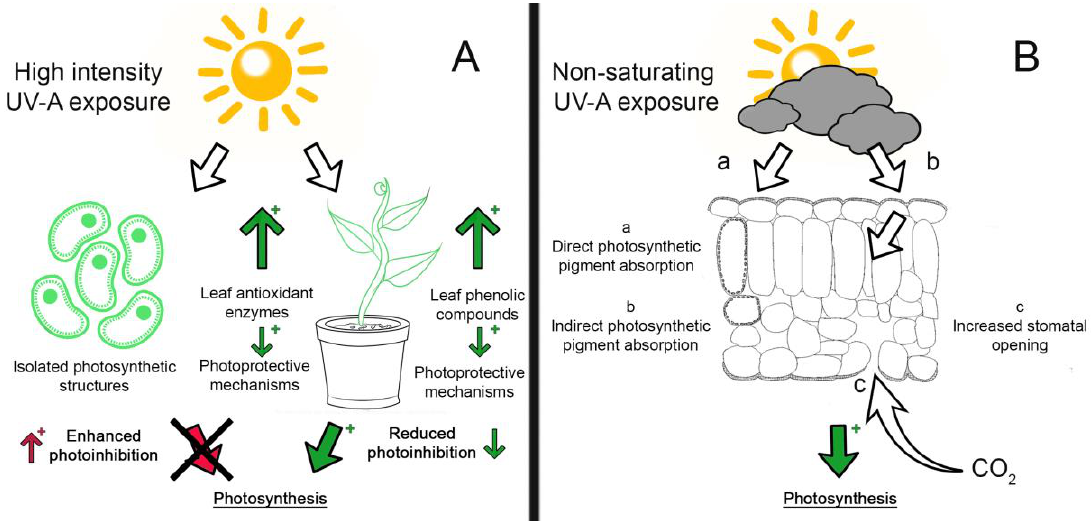
Figure 1. UV-A effects on photosynthesis. A plus (+) sign indicates enhanced response (either positive or negative); a green arrow indicates a positive response, and a red arrow indicates a negative response. ( A ) High intensity UV-A exposure enhanced photoinhibition in isolated photosynthetic structures (chloroplasts and thylakoids), whereas leaves exposed to UV-A activate photoprotective mechanisms (leaf phenols and antioxidant enzymes), reducing photoinhibition. ( B ) Under non-saturating light exposure, direct (a) or indirect (b) UV-A absorption by photosynthetic pigments induced blue-green fluorescence by phenols, and/or (c) increased stomatal opening, leading to enhanced photosynthesis rates [30].